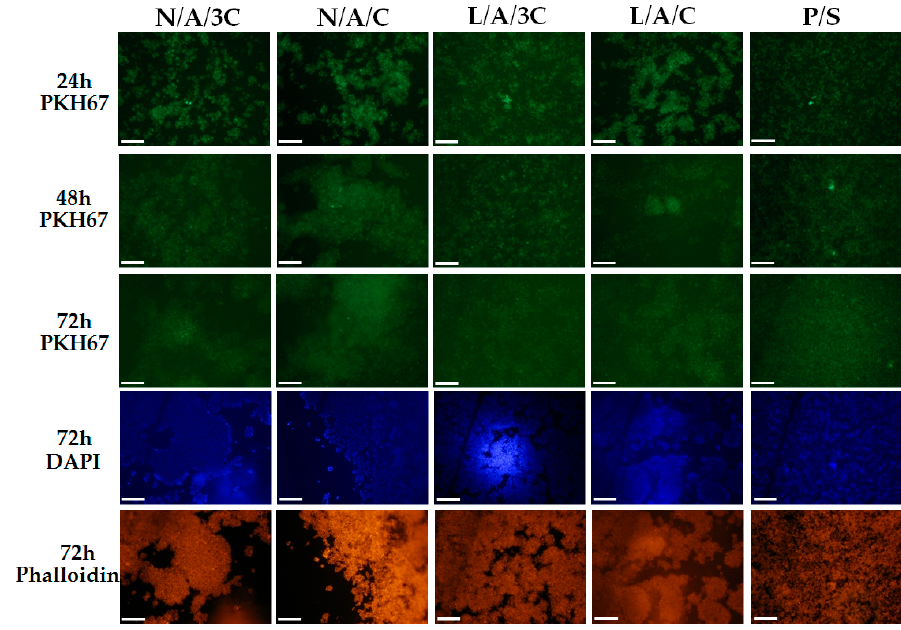
Figure 7. The morphological changes of RAWs264.7 after 24, 48 and 72 h in the cultures. Cellular membranes were stained with PKH67 (light green), nuclei were visualized with DAPI stating (blue dots), while actin cytoskeleton was visualized using atto-565 phalloidin (red stained cell bodies). Magnification used is 100×, and scale bar is 200 µm.